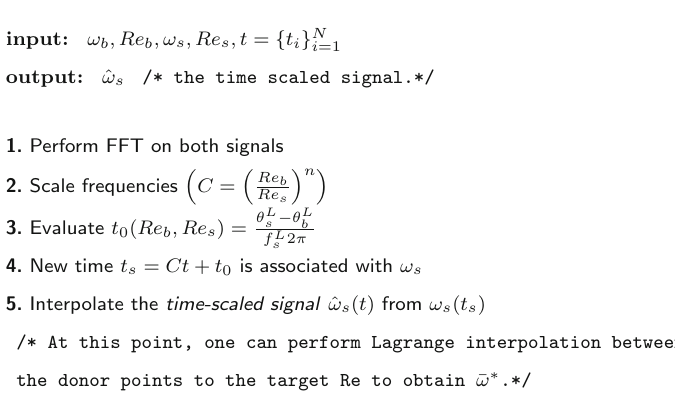
Algorithm-1: Time-scaling algorithm for discrete